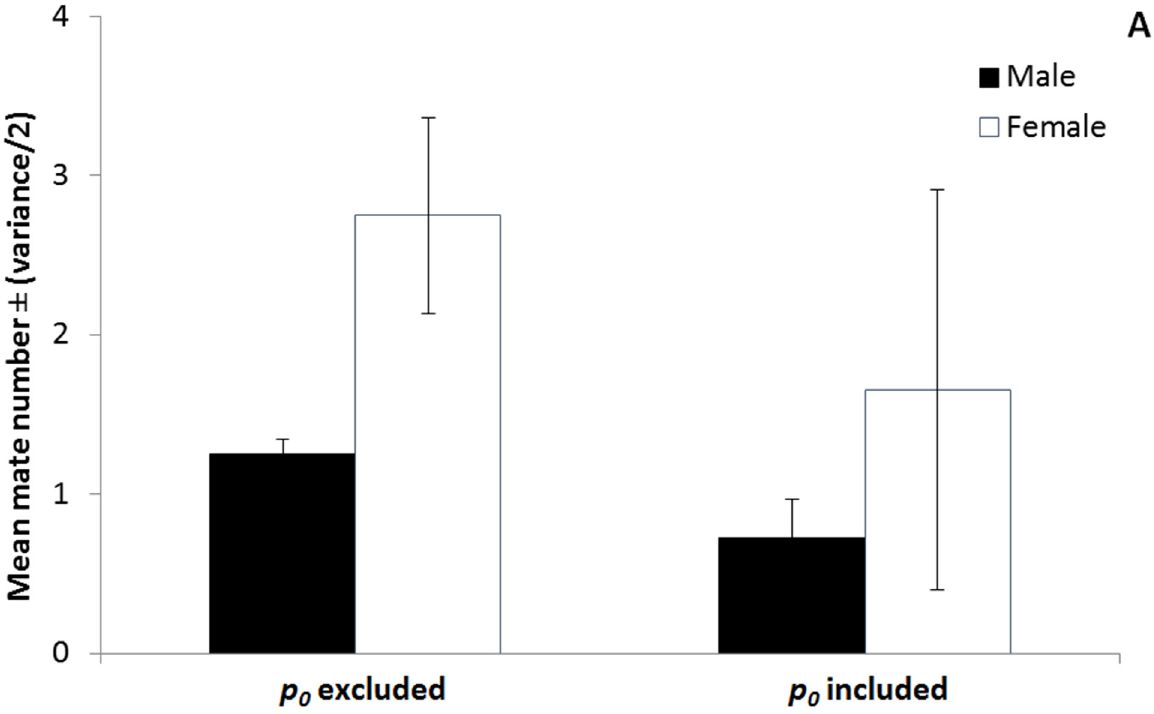
Fig 1. The effect of excluding and including the zero class of individuals ( p 0 ). When the mean and variance in fitness are estimated using mate numbers, for males (black bars) and for females (white bars), including the fraction of the population that fails to mate ( p 0males ; p 0females ) causes the average fitness to decrease and the variance in fitness to increase; error bars represent one half of the variance in